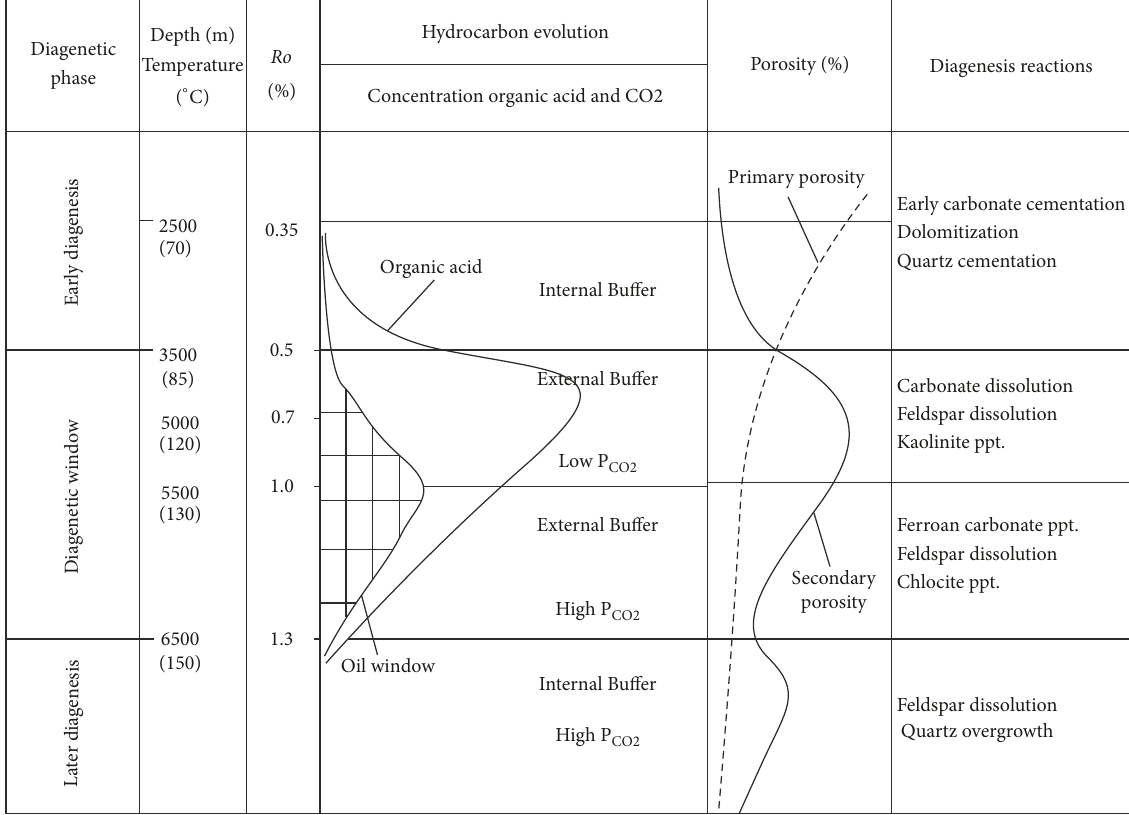
Figure 11: Diagenetic reactions, porosity, and hydrocarbon evolution of the different diagenetic phase in Block